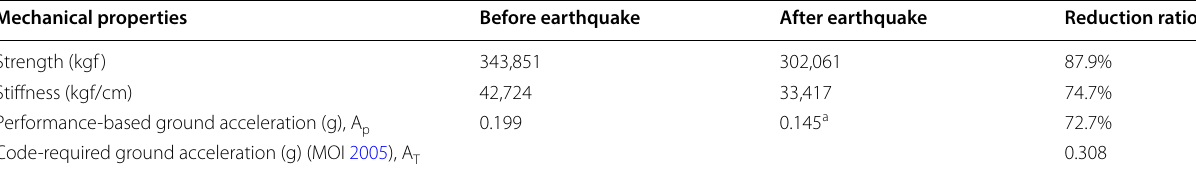
Table 12 Residual performance of seismic capacity.